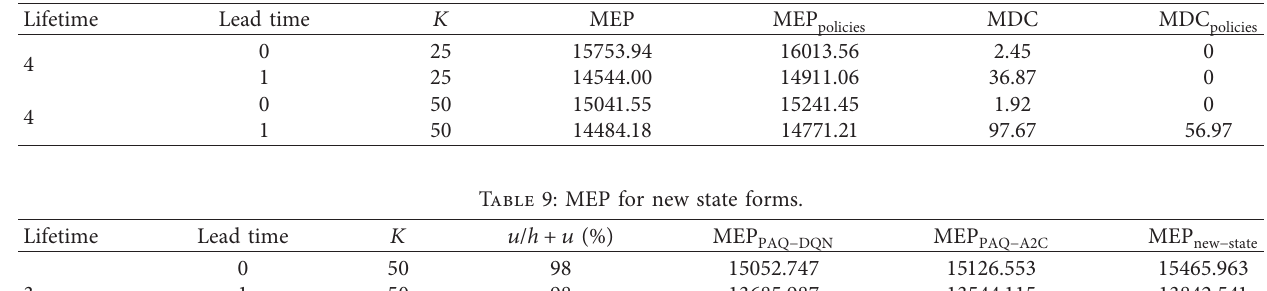
Table 8: Comparison for PAQ-DQN.